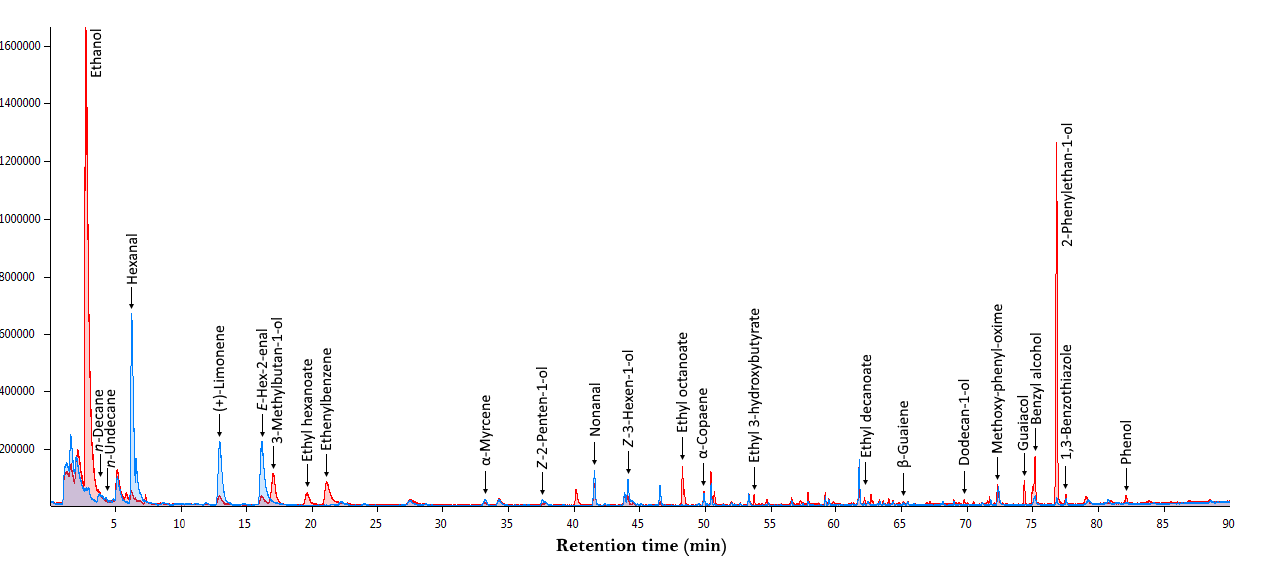
Figure 3. Typical GC-MS chromatogram of the VCs from olive oil storage under CO 2 atmosphere (red chromatogram) and control sample (blue chromatogram). Table 2 . VCs of olive oils.